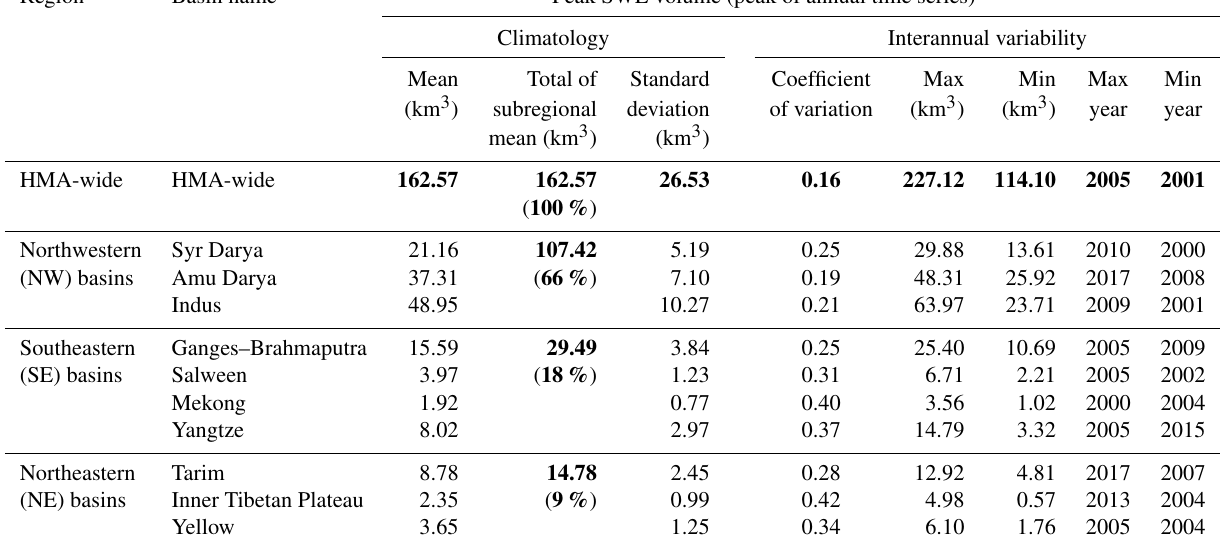
Table 1. Summary statistics for HMA-wide and basin-scale annual peak SWE volume (peak of annual time series) assessed from the 18-year HMASR. The HMA-wide values are shown in the bold text. The subregional peak SWE volumes and their fractions relative to HMA-wide peak SWE volume are shown in the bold text as